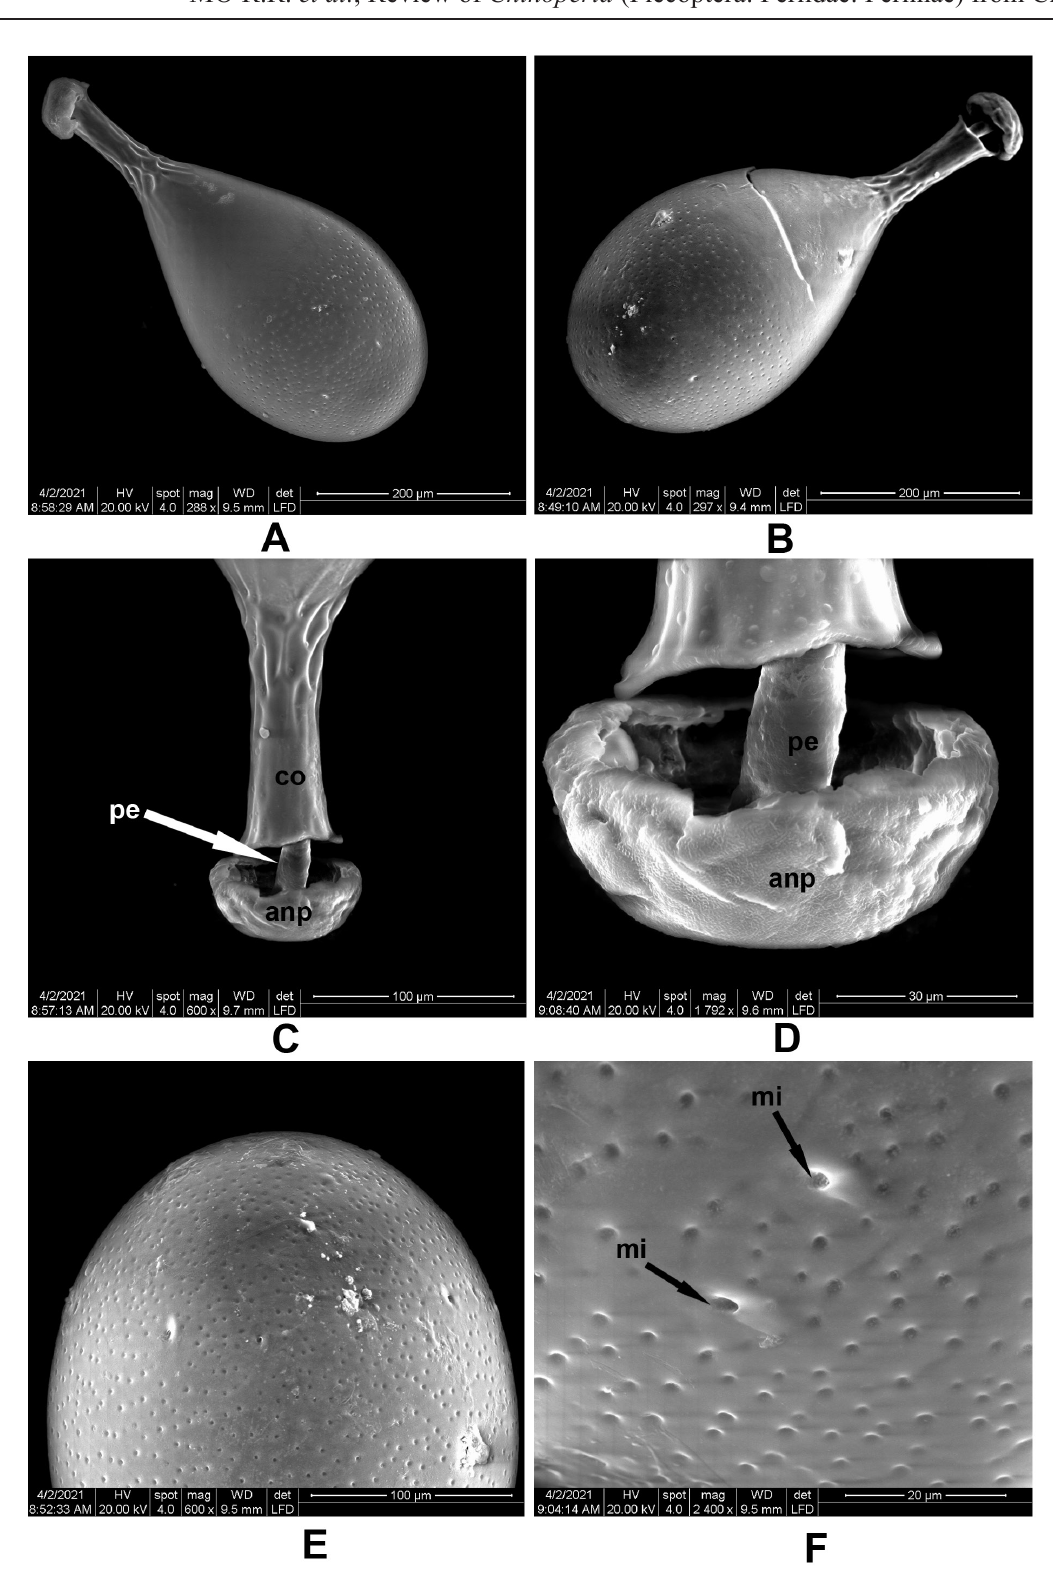
Fig. 14. Chinoperla gorohovi Sivec & Stark, 2010, eggs. A . Entire egg, lateral view. B . Entire egg, lateral view. C . Collar and anchor, lateral view. D . Anchor, lateral view. E . Lid end, lateral view. F . Micropyles (indicated by arrows). Abbreviations: see Material and